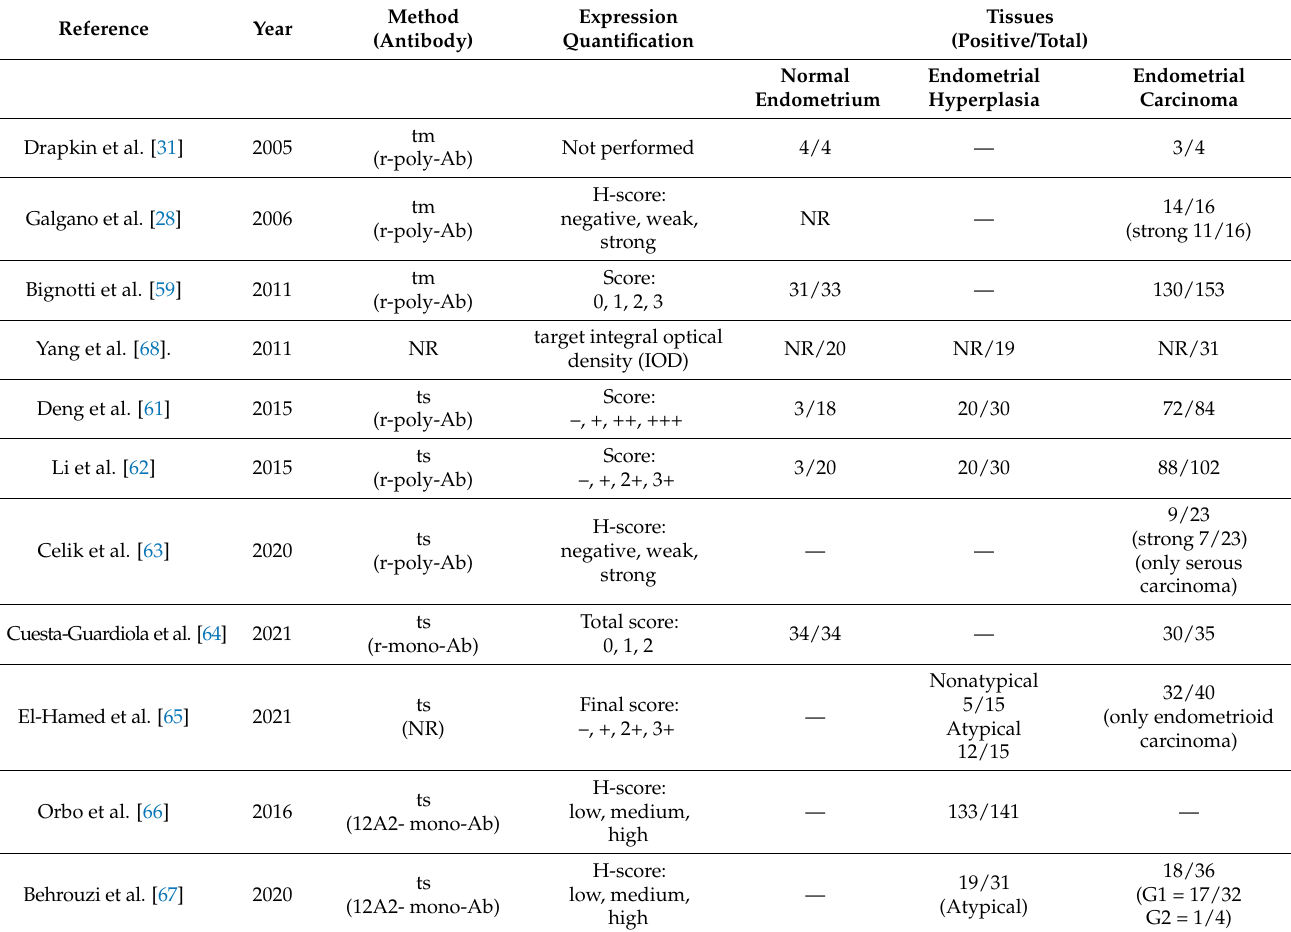
Table 1. Characteristics of 11 studies measuring HE4 tissue protein expression by immunohistochemistry.